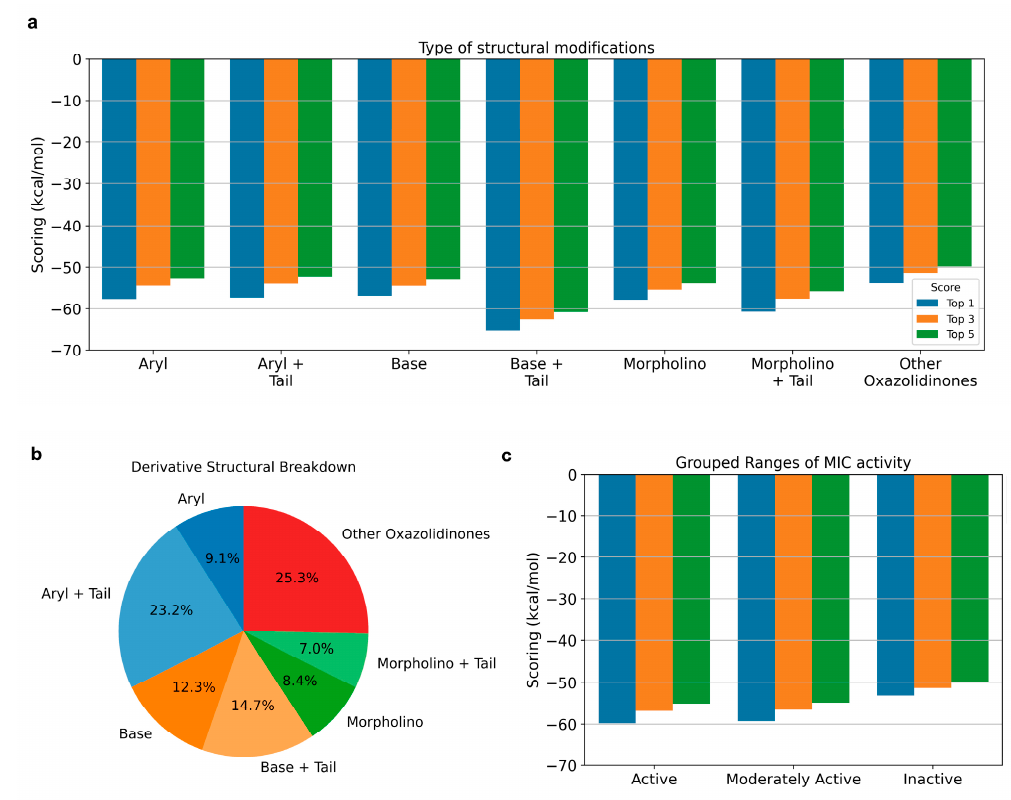
Figure 6. Docking performance of DOCK 6 towards key structural modification of linezolid and correlation with the MIC against S. aureus . ( a ) The average performance of structural modifications when docked with DOCK 6. There are some slight differences between each modification, but nothing of significance. ( b ) Percentage breakdown of the number of structural modifications. ( c ) Some derivatives had activity against S. aureus. Similar to the structural modifications, MIC activities had no significant